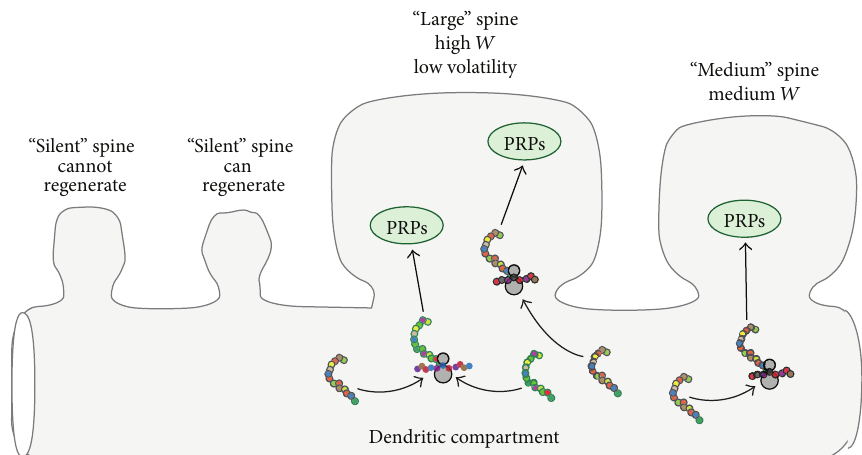
Figure 1: Schematic illustrating key model elements. Two silent synapses, corresponding to two small dendritic spines, are adjacent to two activesynapsescorrespondingtolargerspines.Onlythesilentsynapsenexttoanactivesynapseiscurrentlyeligibleforregeneration.Although the dynamics of mRNAs or locally synthesized proteins are not simulated, large synapses are implicitly assumed to capture more of these resources. This is illustrated by a greater flow of mRNAs (colored strands) onto ribosomes near the largest synapse and a greater flow of plasticity-related proteins (PRPs) into that synapse. This resource capture attenuates the amount of resource available to support growth of all synapses in the cluster. The average amplitude of LTP events is thereby reduced when more synapses in a given cluster are strong.